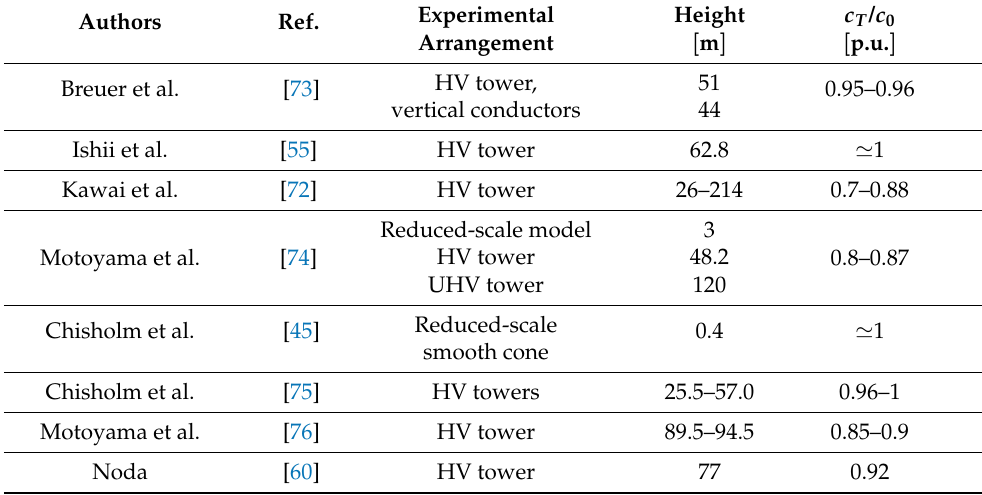
Table 1. Common values of surge velocity deduced from experimental activities to assess propagation along transmission line